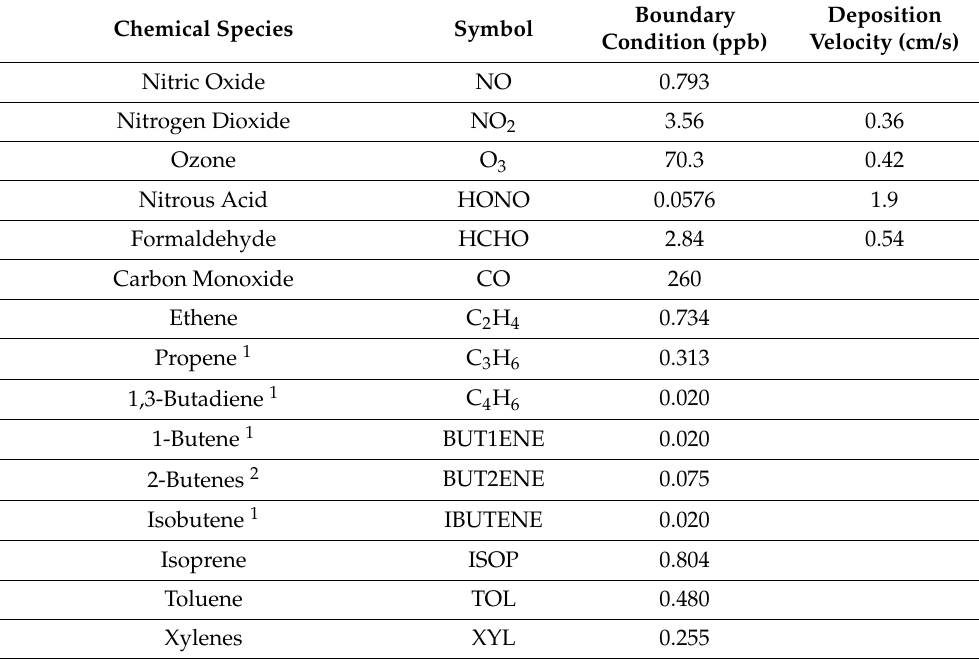
Table 2. Chemical boundary conditions derived from CMAQ 8 h average concentrations for 10:00–18:00 LST on 29 June 2018 at a location slightly north of Oak